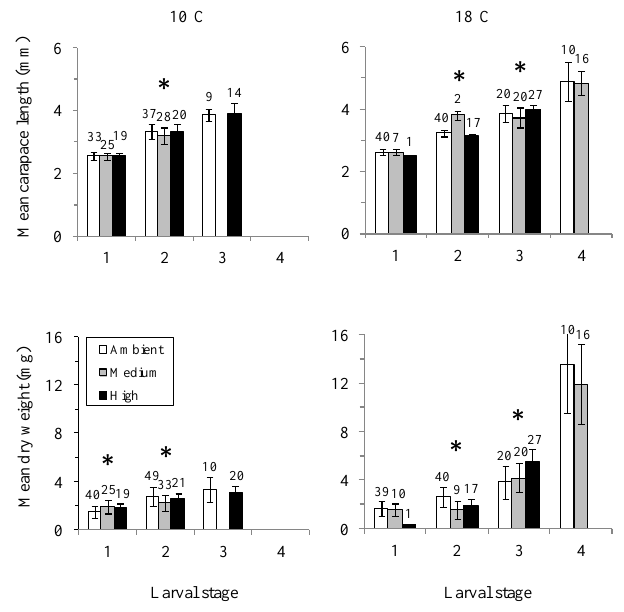
Figure 4. Fig. 4. Mean carapace length (mm) and mean dry weight (mg) with one standard deviation at each larval stage of Homarus gammarus undergoing ambient, medium p CO 2 and high p CO 2 treatment run at 10 and 18 ◦ C. Number of observations in each stage is given above the column. Note that at 10 ◦ C only three larvae reached stage 4 (high p CO 2 treatment), but they only survived for two days. Am- bient is raw water from 90m depth. Star indicates significant dif- ferences based on Kruskal–Wallis non-parametric test at p = 0.05 level.